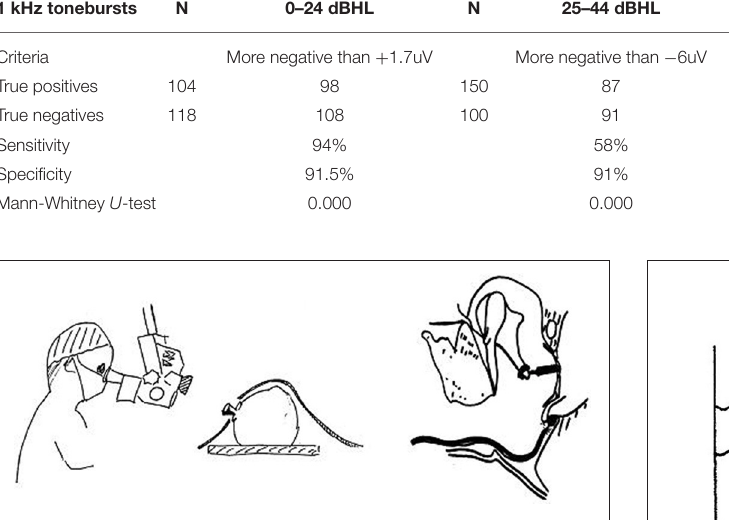
FIGURE 6 | The arrangement for monitoring middle ear surgery. The transducer is placed on the operating microscope close to the lens.